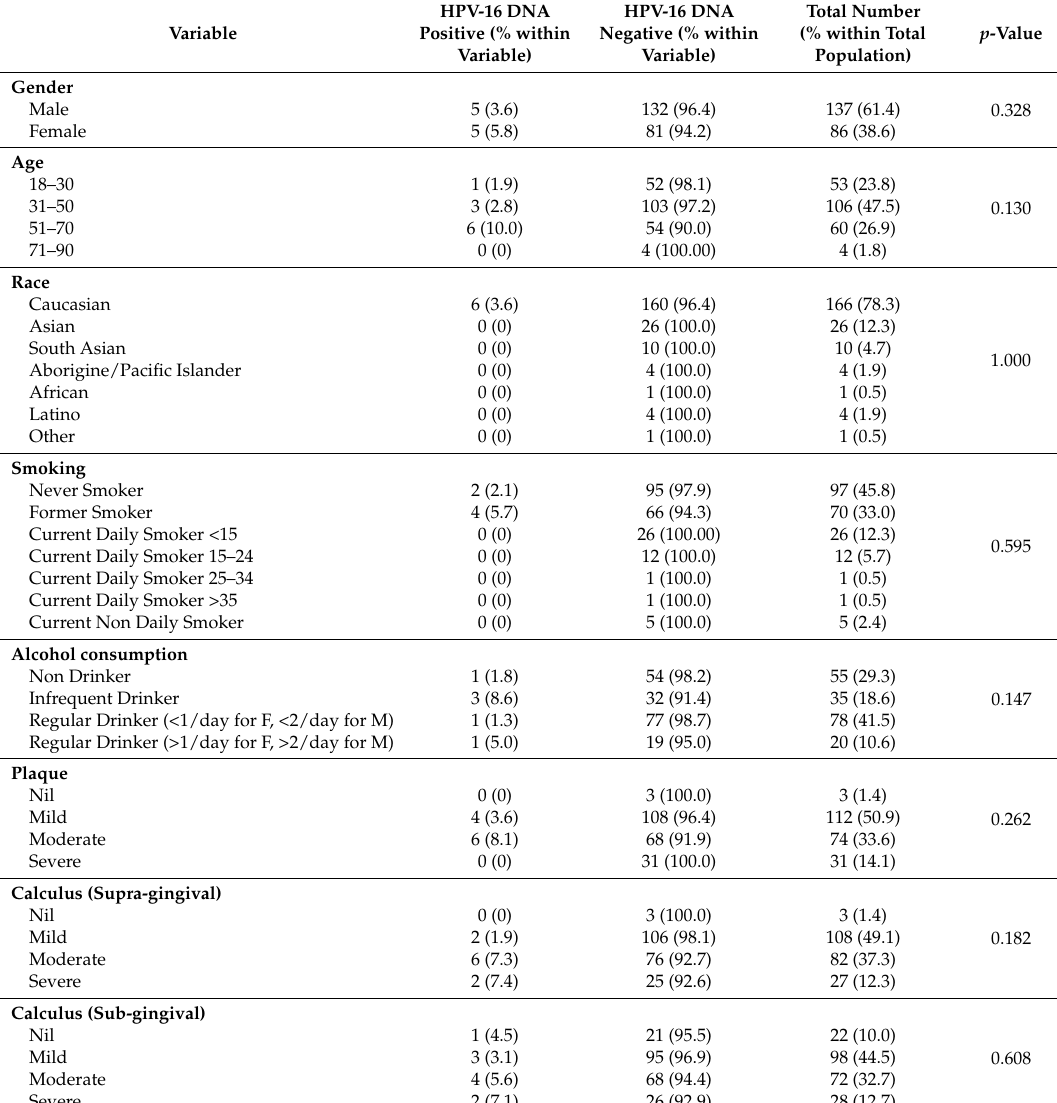
HPV-16 DNA Total Number HPV-16 DNA p -Value Negative (% within (% within Total Positive (% within Population) Variable) Variable)